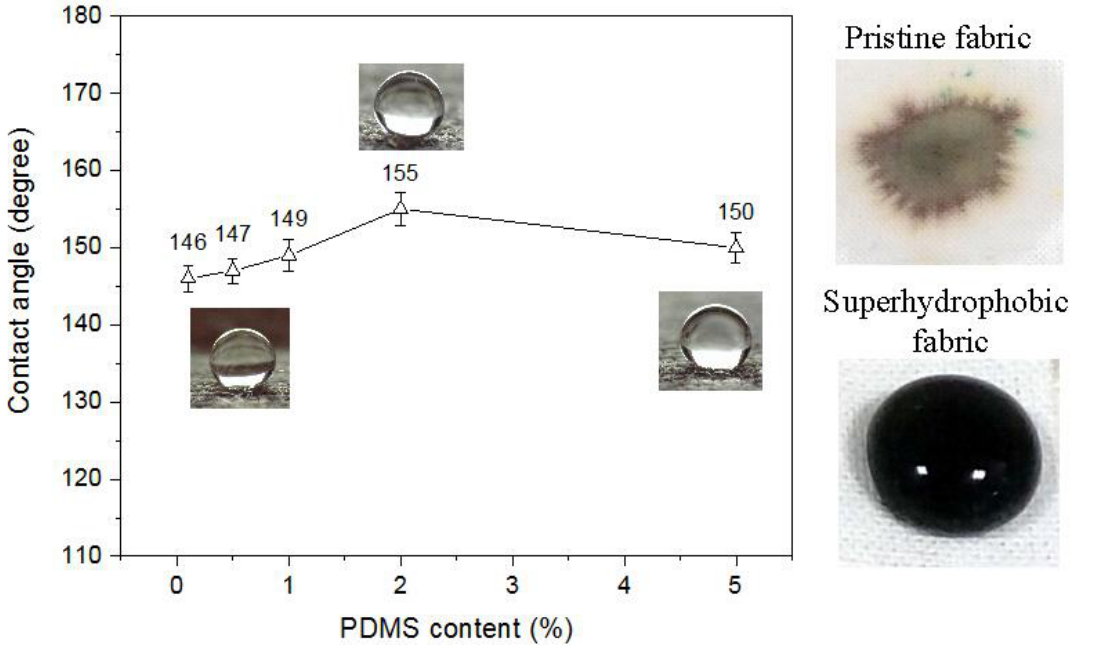
Figure 4. The effect of PDMS content on contact angle of treated fabrics. Table 1. Comparison of hydrophobicity of different substrates using various approaches.